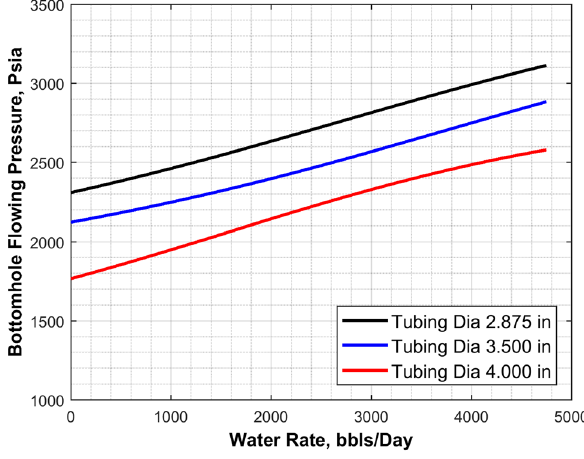
Fig. 10 Effect of changing water rate on flowing bottom-hole pres- sure at tubing IDs of 2.875, 3.500 and 4.000